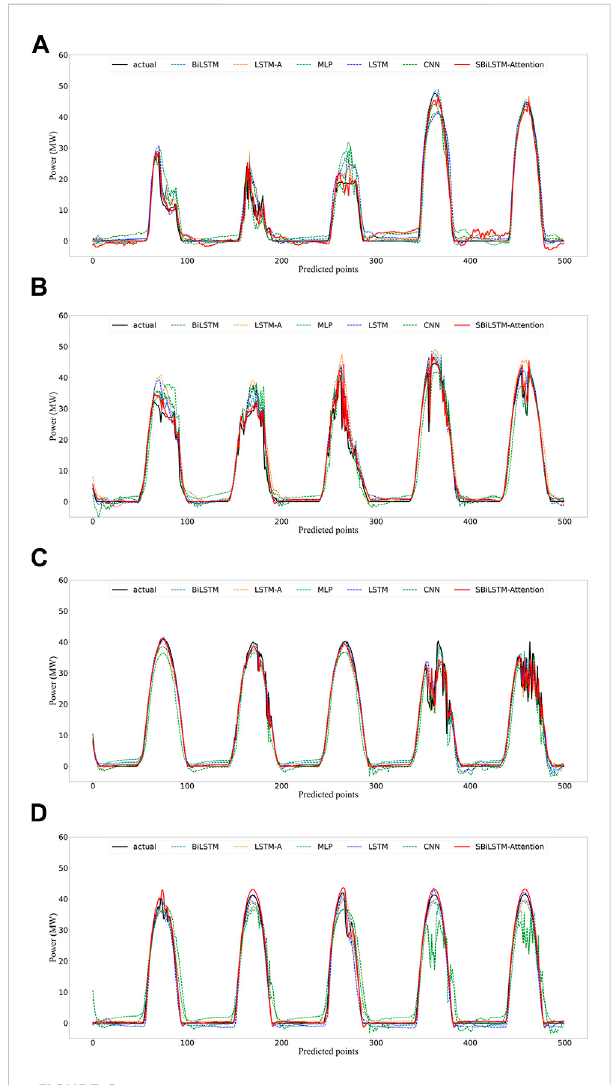
FIGURE 6 Comparison of January, April, July and October forecasts.